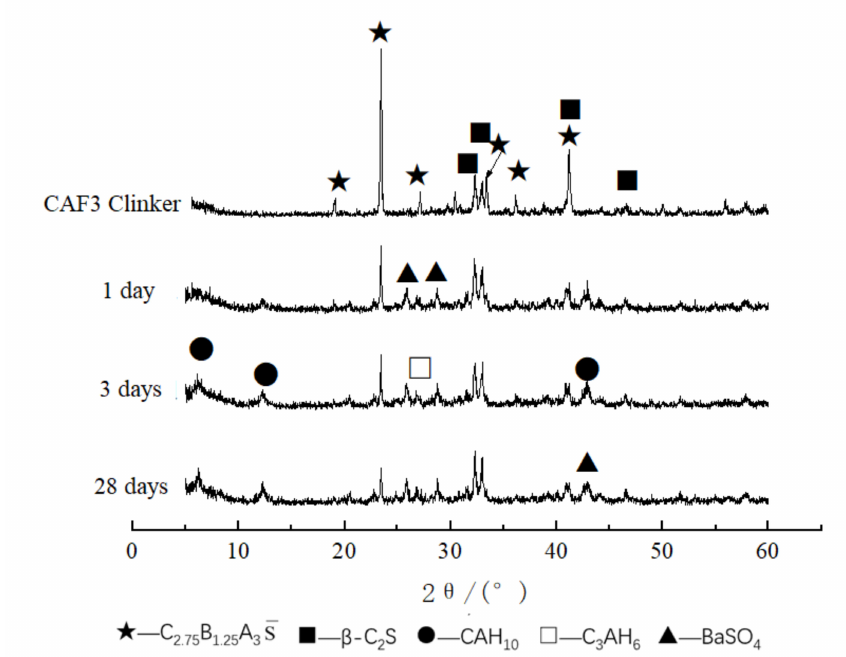
Figure 7. XRD patterns of CAF3 at different curing times.